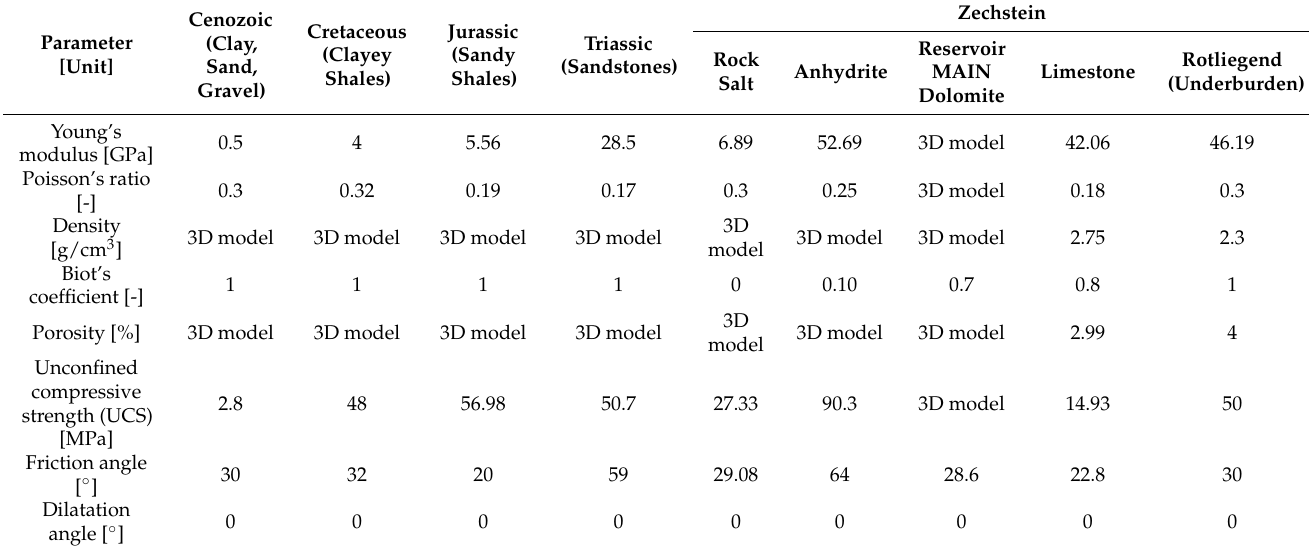
Table 1. Calculated and estimated values of petrophysical and geomechanical parameters in 3D model of the study area. Cenozoic Parameter (Clay, [Unit] Sand, Gravel) Young’s modulus [GPa]